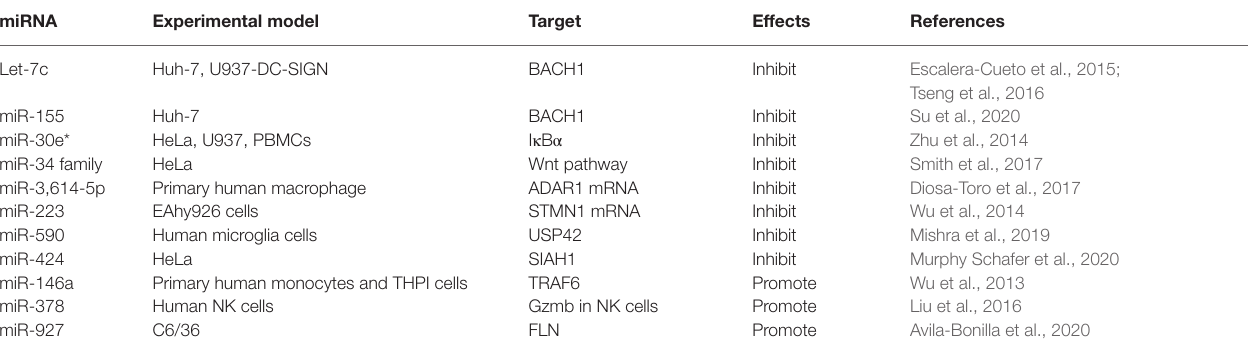
TABLE 2 | microRNAs that inhibit or promote dengue virus (DENV) replication by regulating host factors.